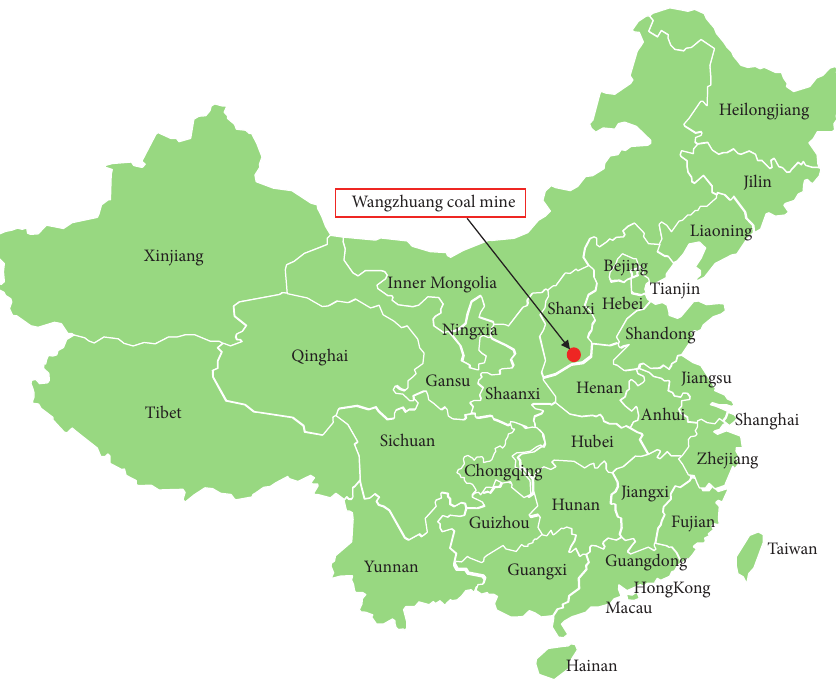
Figure 1: Location of the Wangzhuang coal mine.